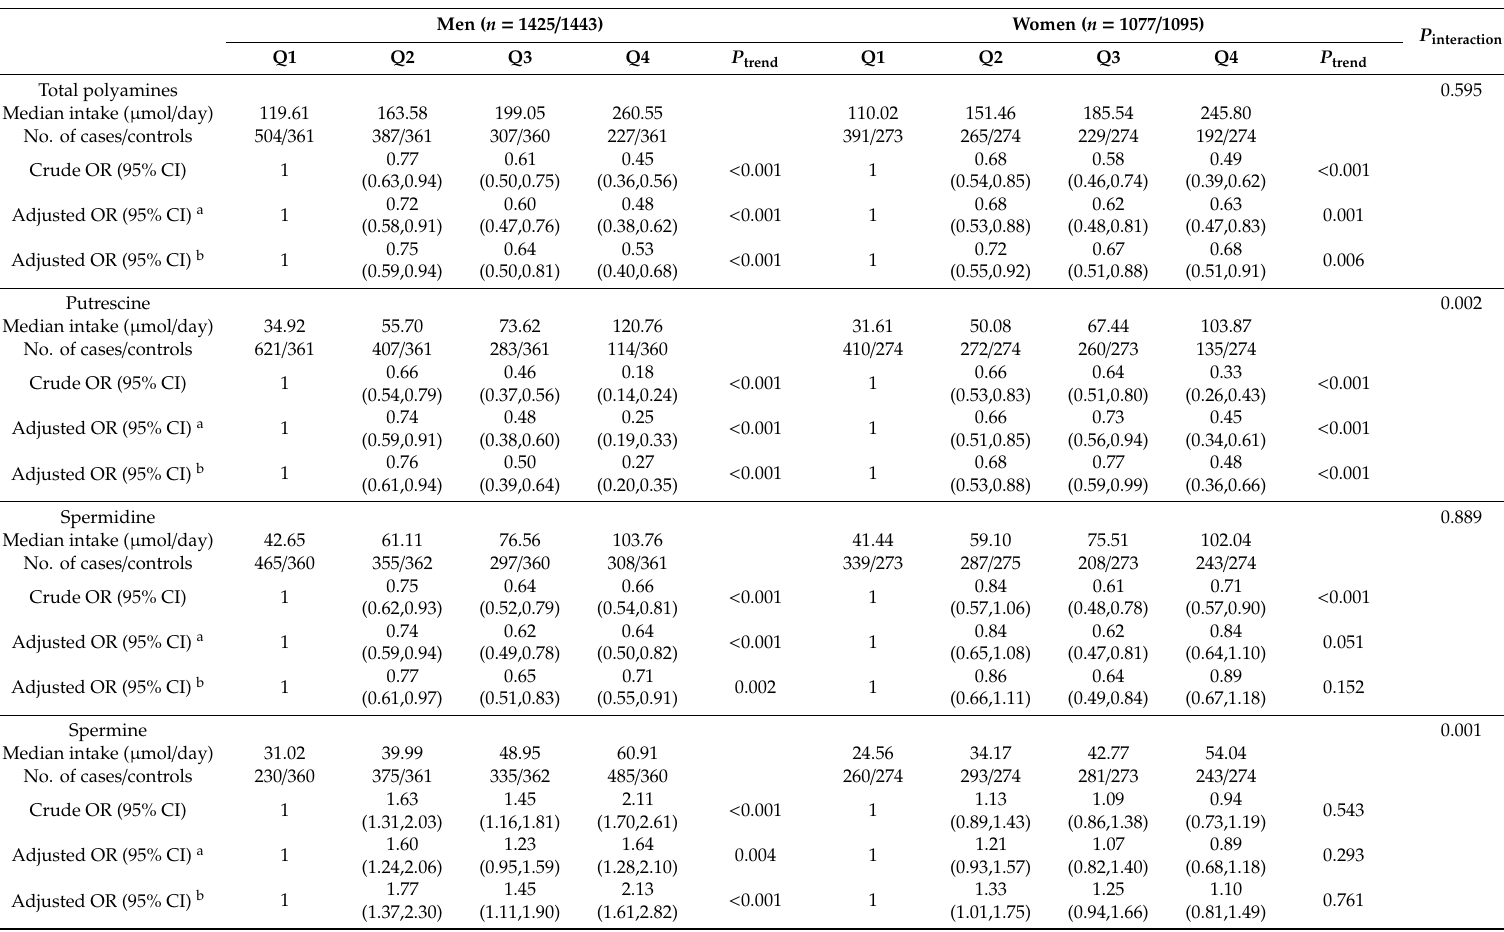
Table 4. Associations between polyamines intake and colorectal cancer risk stratified by sex (Odds ratios and 95% confidence